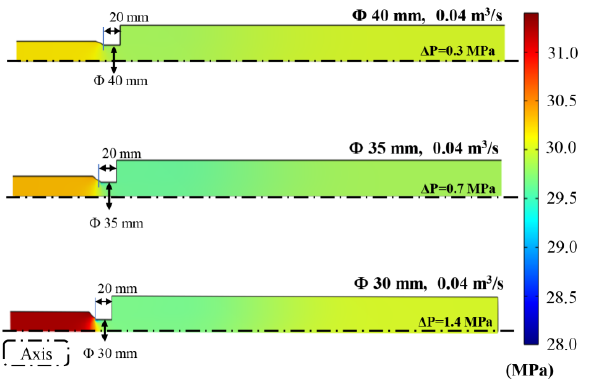
Figure 11. Effect of the ball seat diameter on the pressure distribution; the fluid viscosity was set as 100 mPa·s.